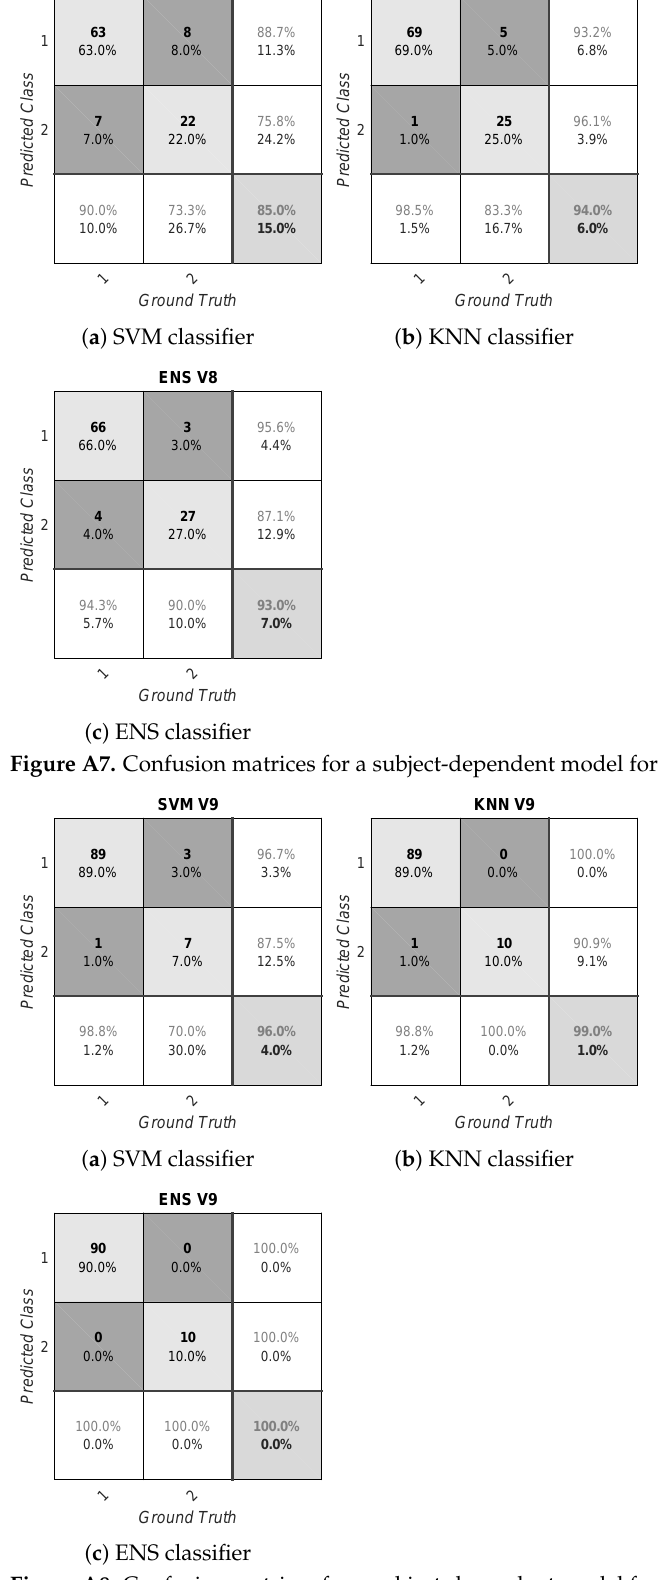
Figure A8. Confusion matrices for a subject-dependent model for